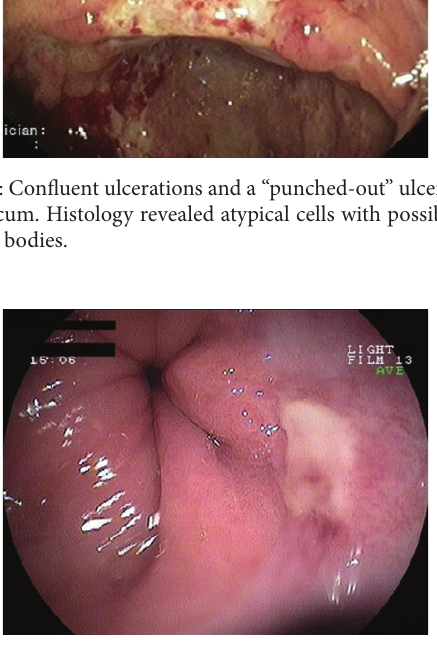
Figure 3: A small superficial ulcer at the gastroesophageal junction. PCR analysis in biopsies was positive for CMV